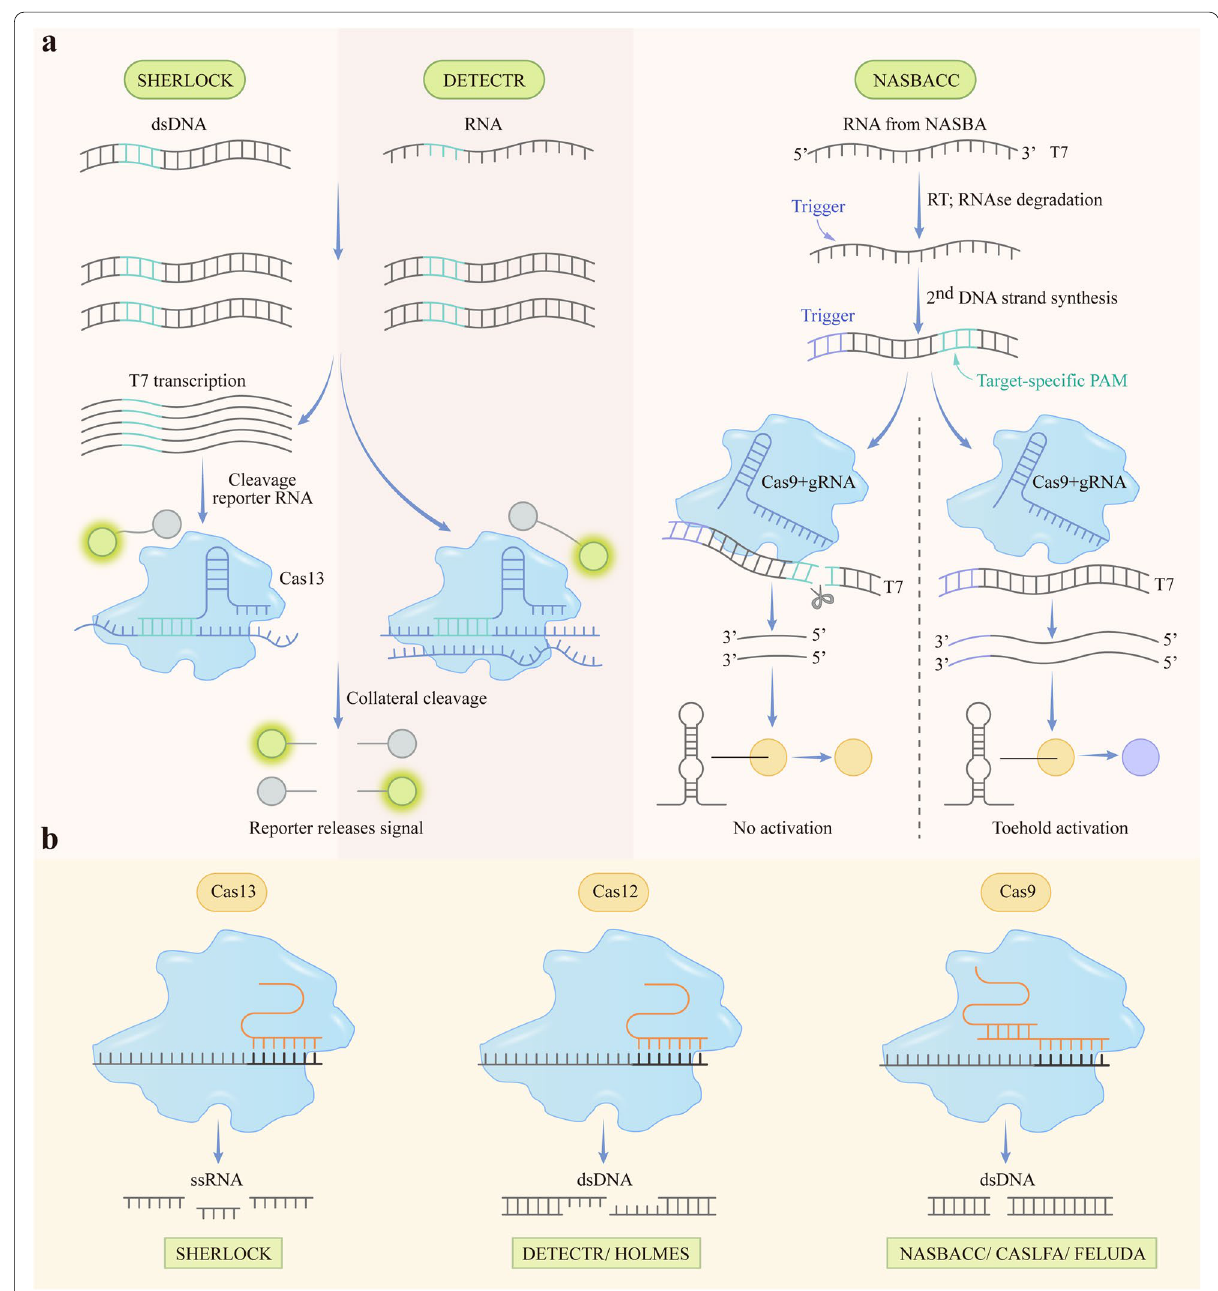
Fig. 4 Two strategies for CRISPR-based diagnostics and comparison and detection characteristics of the properties of CRISPR/Cas13/Cas12/Cas9 system. A Two strategies for CRISPR-based diagnostics. Left: Schematic of SHERLOCK and DETECTR. DNA or RNA is amplified by RPA or RT-RPA, respectively. T7-transcribed RNA is the amplified product by RPA, and the CRISPR/Cas13 (used in SHERLOCK) and CRISPR/Cas12 (used in DETECTR) systems bind of the crRNA to the complementary target sequence to activate the Cas enzyme and trigger collateral cleavage of quenched fluorescent reporters. Right: Schematic of NASBACC. RNA targets are amplified through NASBA, from reverse transcription (RT) to complementary DNA, a sequence-specific primer that appends a trigger sequence (purple) for the toehold sensor was used. B Comparison and detection characteristics of the properties of CRISPR/ Cas13/Cas12/Cas9 system. PAM: protospacer adjacent motif; PFS: protospacer flanking site; DSB: double-strand